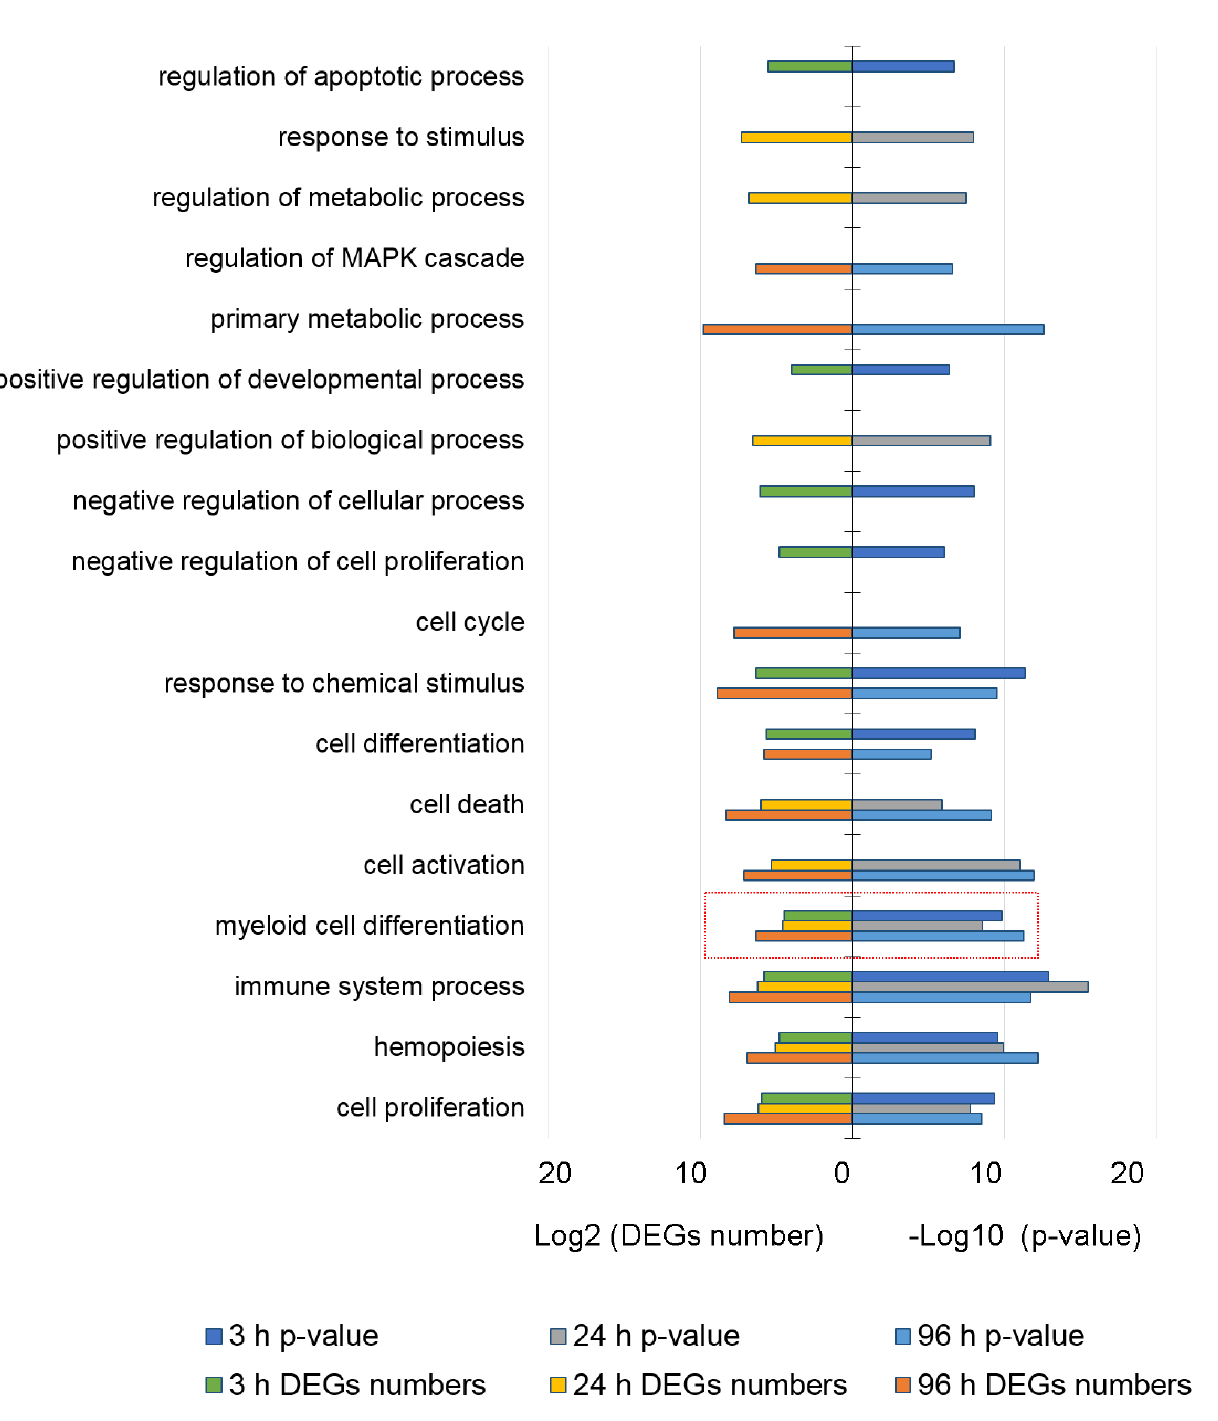
Figure 2. The functional GO analysis of differentially expressed genes (DEGs) of HL-60 cells at 3 h, 24 h, and 96 h after ATRA treatment. The number of DEGs (Log2 transformed) and p -value (-Log10 transformed) are provided on the x-axis. The groups from the category of “Biological process” are on the y-axis. The threshold adjusted p -value < 10 − 4 . The group of “myeloid cell differentiation” (MCD, GO: 0030099) is marked by red color.